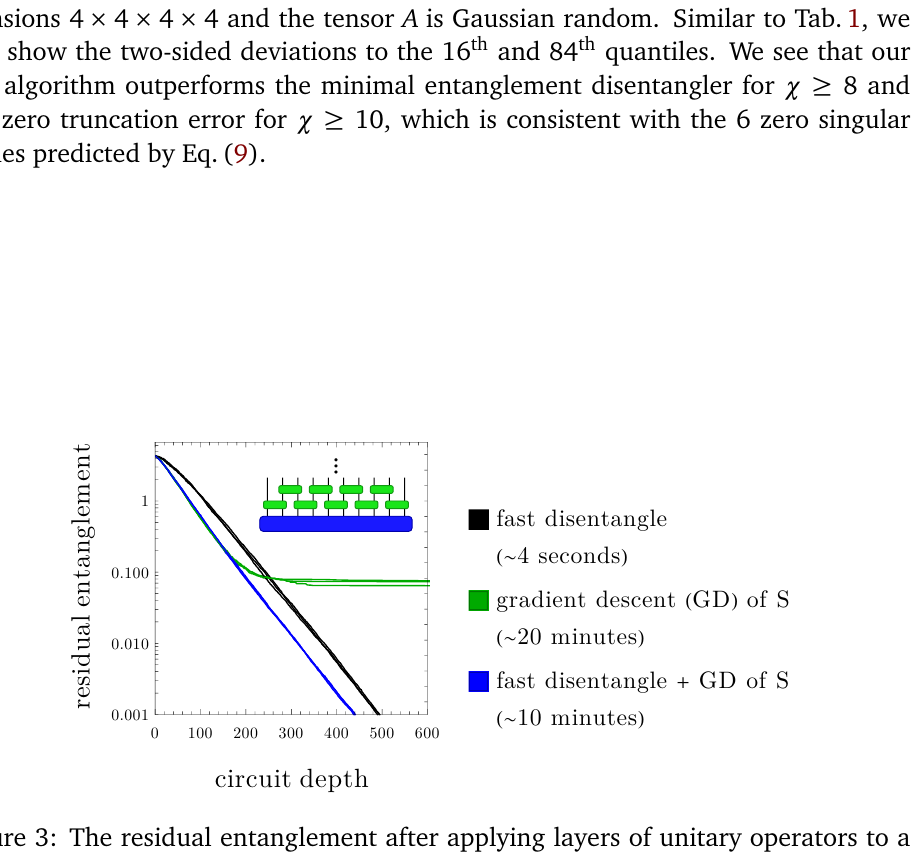
Figure 3: The residual entanglement after applying layers of unitary operators to a random 10-qubit wavefunction for various algorithms. The residual entanglement is the maximum entanglement across any left / right cut of the wavefuntion. We ap- ply each method to the same three random wavefunctions, resulting in three nearly overlapping lines for each method. We also show the amount of CPU time used for each method to obtain the data shown. (inset) Two layers (i.e. depth = 2) of unitaries acting on the